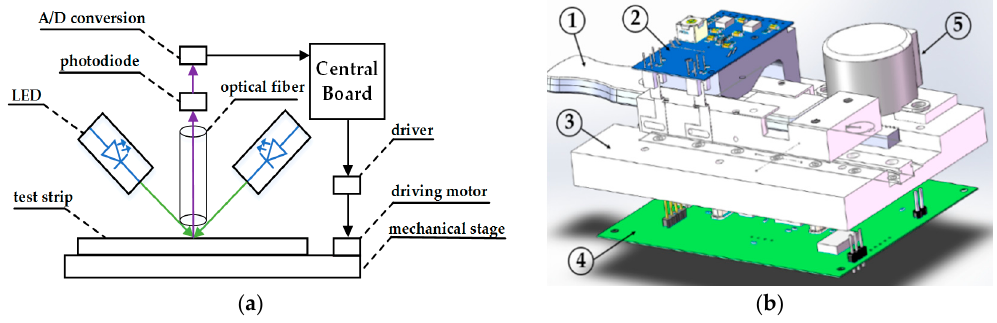
Figure 1. ( a ) Schematic diagram of photoelectric detection system; and ( b ) the 3D structure of the photoelectric detection system; with 1: test strip; 2: photoelectric module; 3: mechanical stage; 4: central board; and 5: driving module.